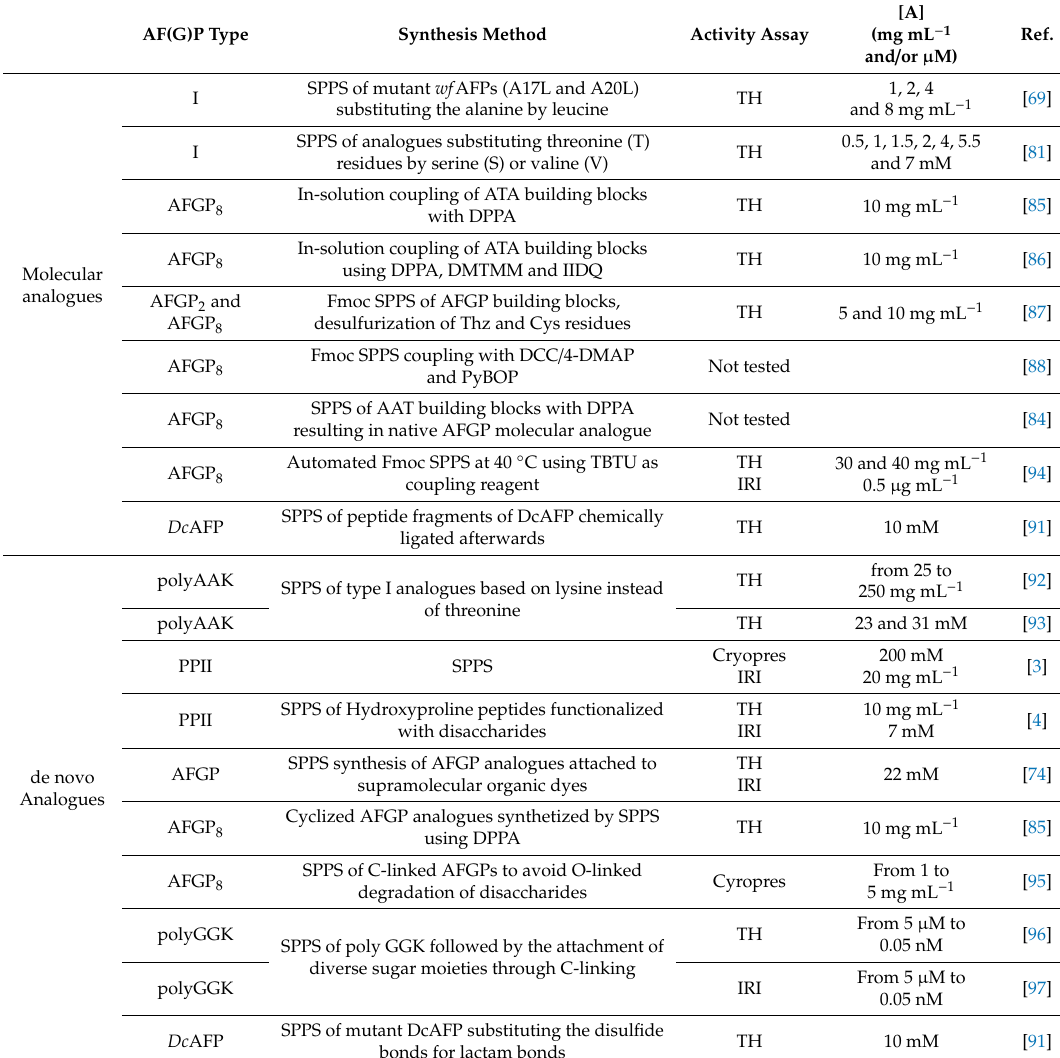
Table 1. Overview of studies on peptidic antifreezes listing compound type, synthesis method, activity assay type and protein concentration [A]. AF(G)P Type Synthesis